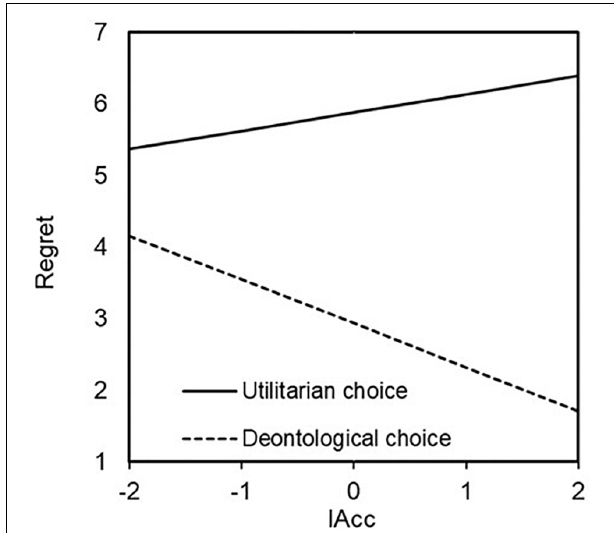
FIGURE 3 | Effect of interaction between IAcc and choice on regret in Orphanage. The higher they rated interoceptive accuracy, the lower they rated regret when they made a deontological choice but not when they made an utilitarian choice (utilitarian choice B = 0.257, n.s .; deontological choice B = –0.613, p < 0.000).